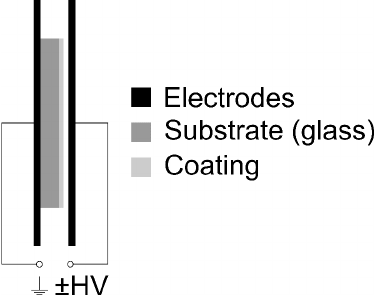
Figure 1. Sketch of setup to polarize the samples.